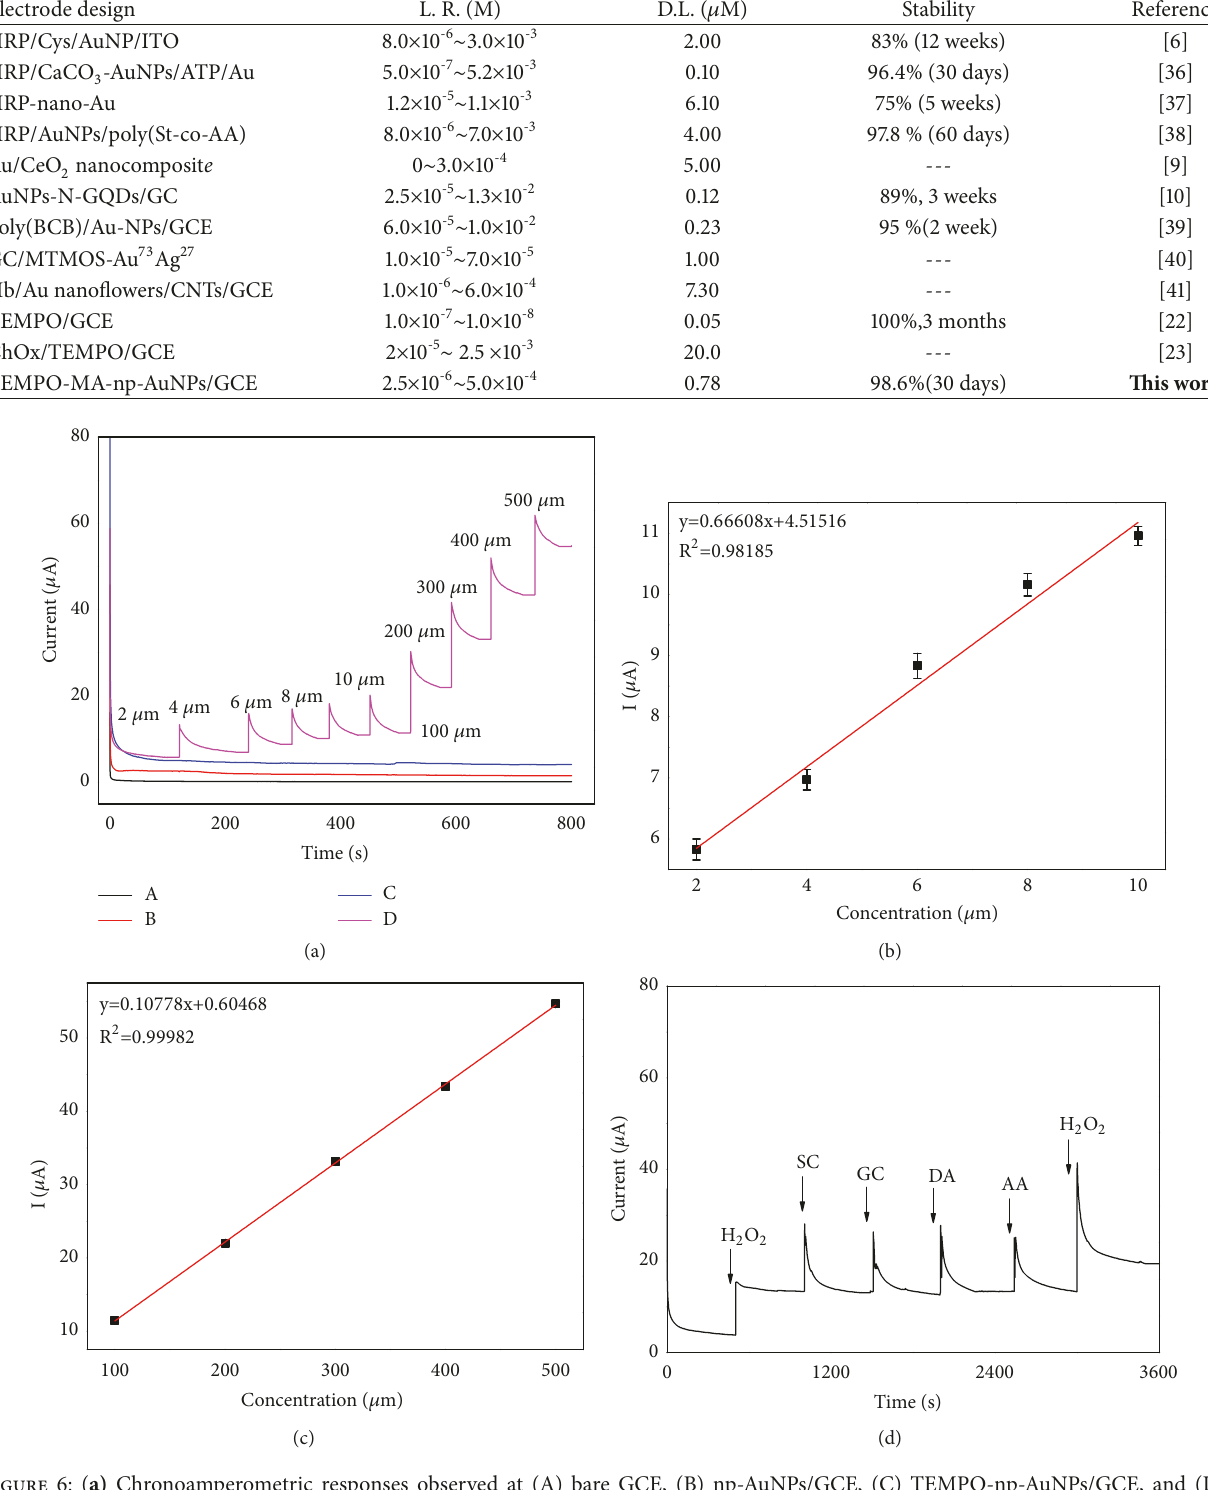
Figure 6: ( a) Chronoamperometric responses observed at (A) bare GCE, (B) np-AuNPs/GCE, (C) TEMPO-np-AuNPs/GCE, and (D) TEMPO-np-AuNPs/GCE after successively injecting H 2 O 2 , in 0.1 M PBS (pH=7.0). Applied potential: 1.10 V and the calibration plot between the oxidation current and the H 2 O 2 concentration (b and c). ( d) Amperometric response of H 2 O 2 and interferants at TEMPO- np-AuNPs/GCE at 1.10V in PBS (0.1 M, pH = 7.0). Injection sequence: 0.1mM H 2 O 2 , 100 mM SC, 100 mM GC, 100 mM DA, 100 mM AA, and 0.2 mM H 2 O 2